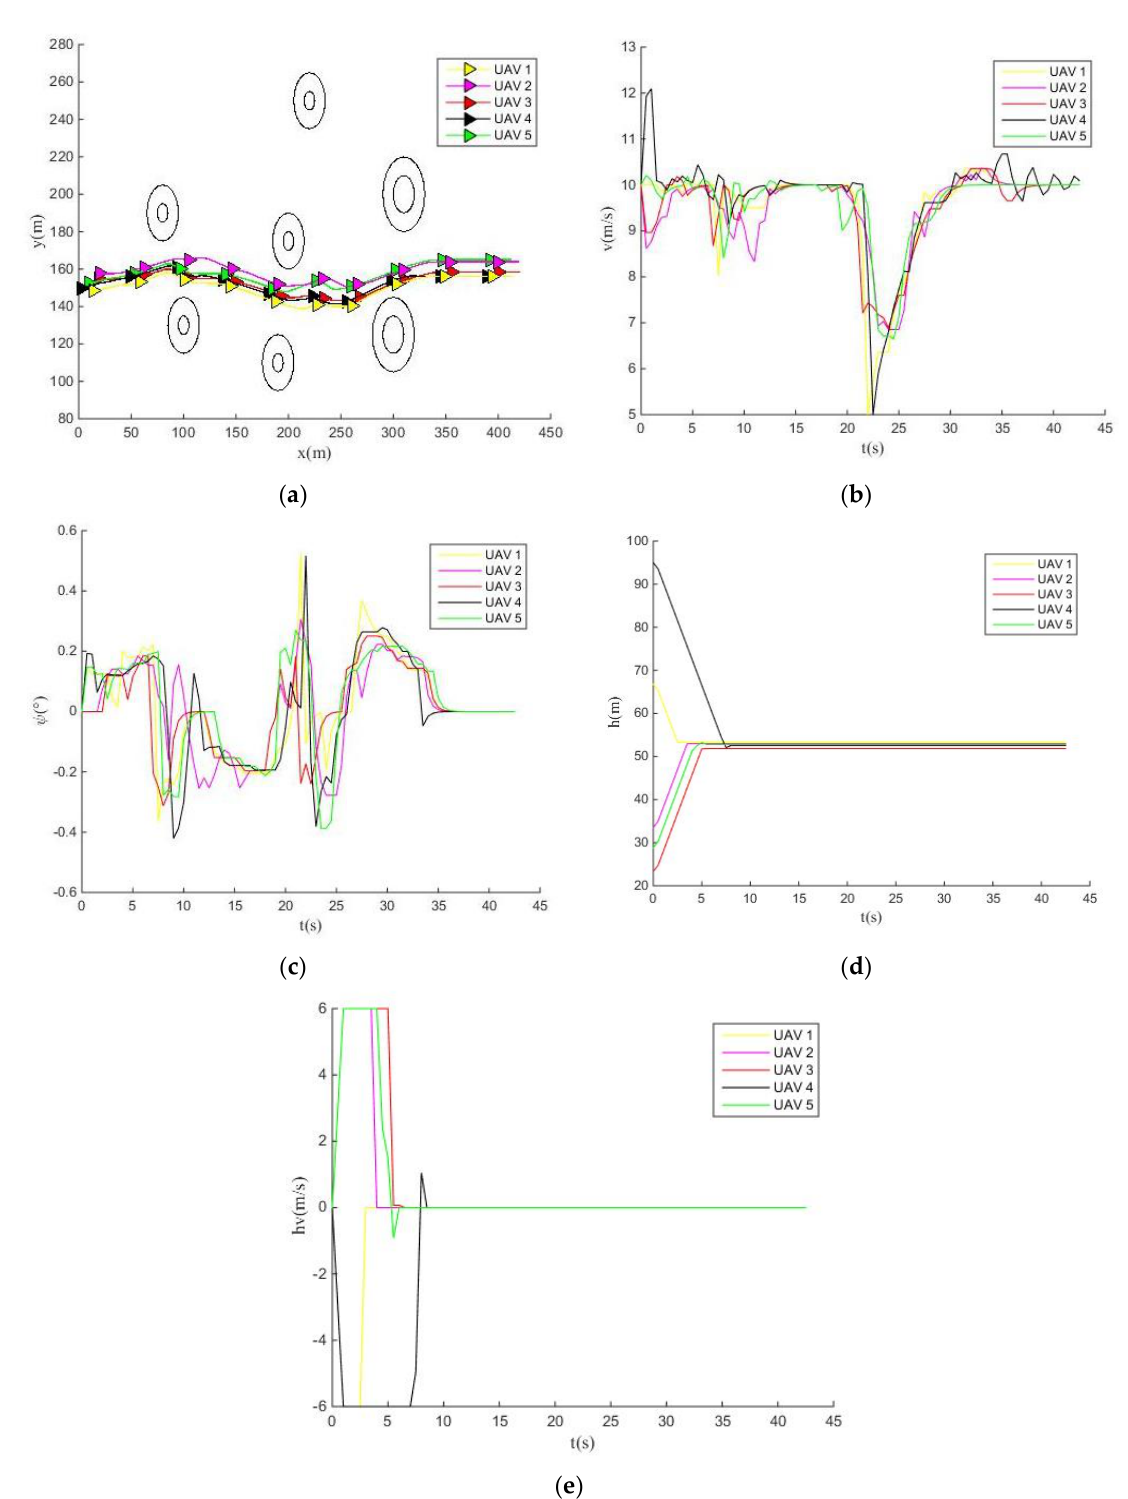
Figure 13. MPIO optimizes the flight change curves of UAVs. ( a ) Obstacle avoidance curve of UAVs; ( b ) Horizontal airspeed change curves of UAVs; ( c ) Yaw angle change curves of UAVs; ( d ) Flight altitude change curves of UAVs; ( e ) Altitude rate change curves of